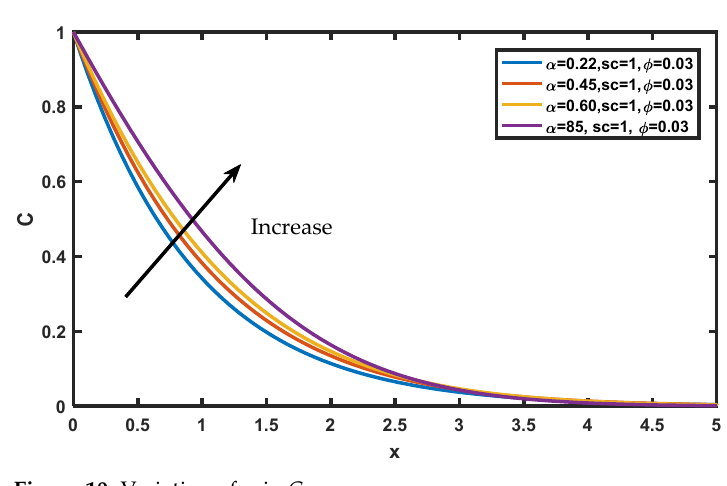
Figure 9. Variation of α in θ .